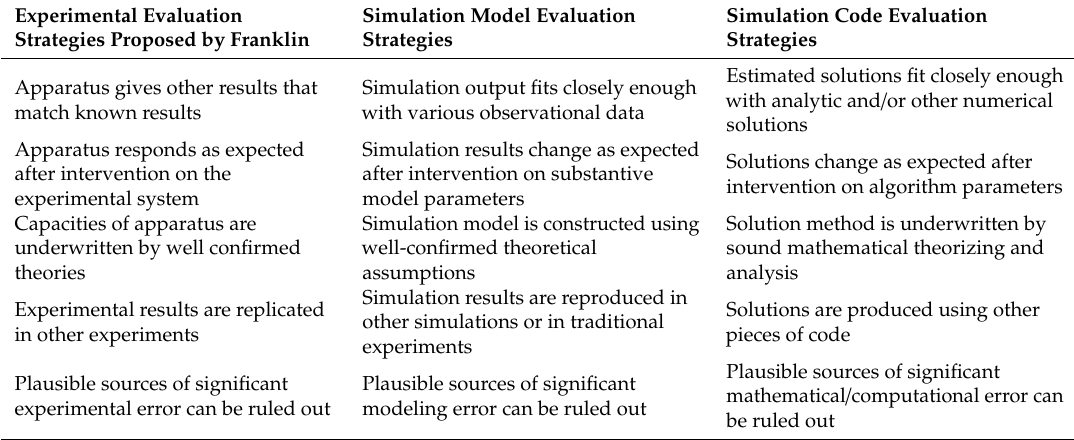
Table 1. Strategies for Enhancing the Epistemological Power of Computer Simulations. Source [21]. Experimental Evaluation Strategies Proposed by